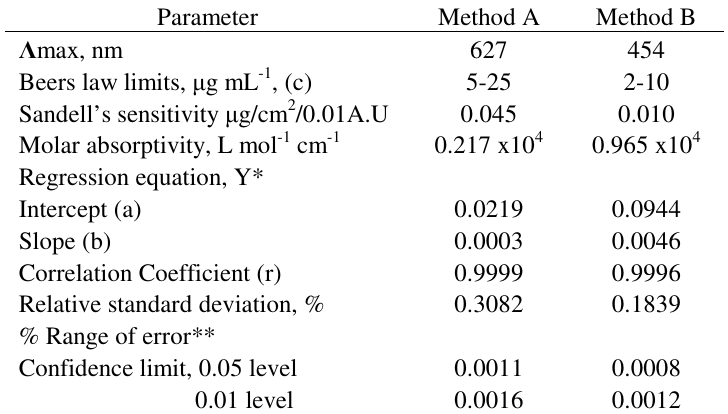
Table 1. Optical characteristics and precision of the proposed method A and B